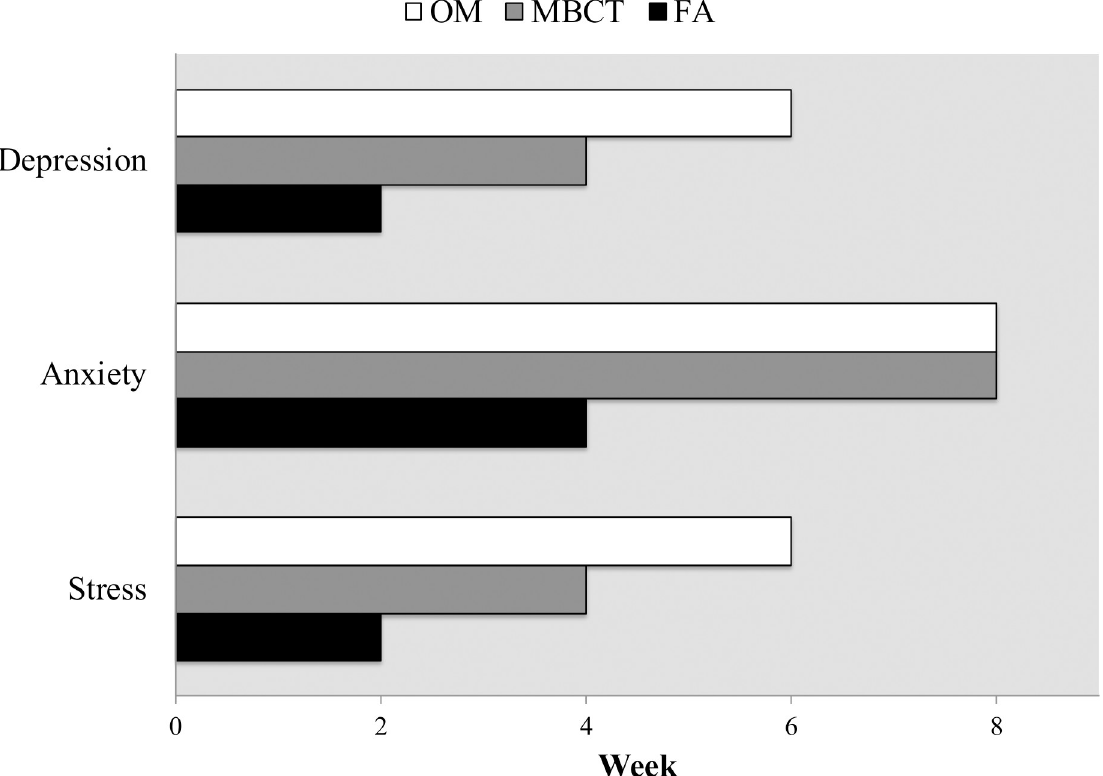
Fig 4. Number of weeks until first significant improvement (FSI) from baseline in stress, anxiety and depression (DASS) during the 8-week intervention.